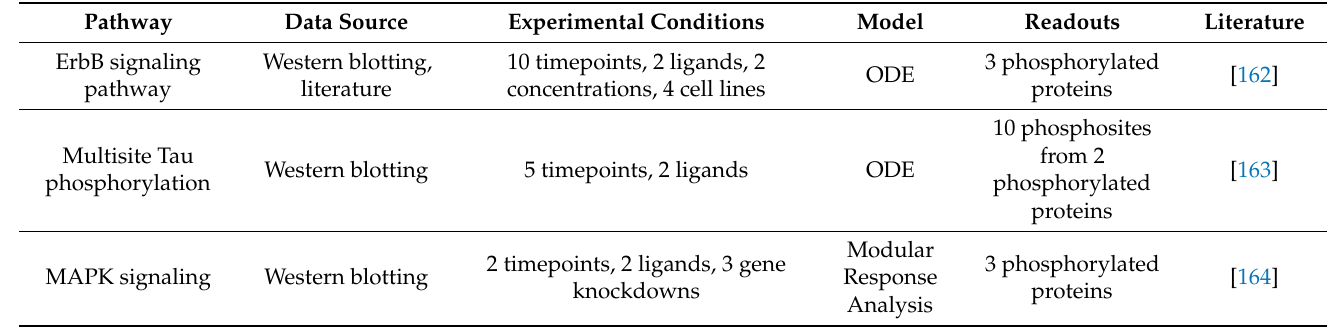
Table 2. Selected applications of phosphorylation data in mathematical